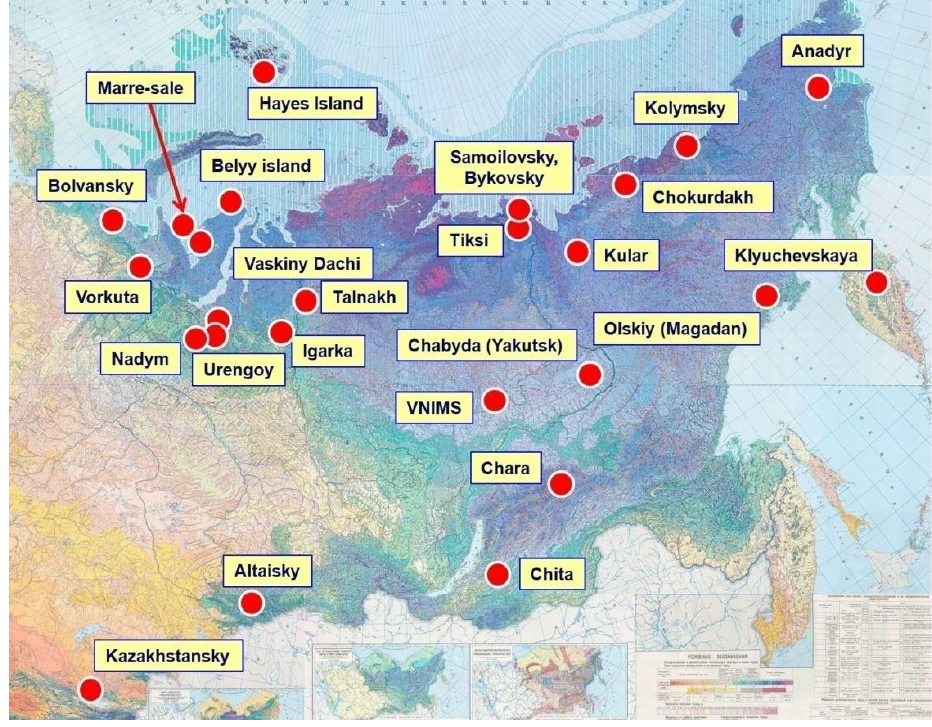
Figure 5. The map of permafrost monitoring sites in Russia.